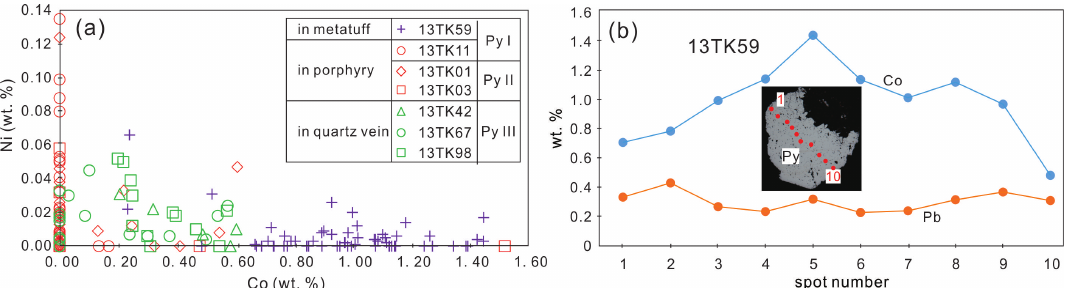
Figure 9. ( a ) A nickel versus cobalt plot for pyrite hosted in porphyry, metatuff, and quartz veins; ( b ) A diagram showing a profile of cobalt and lead concentration for an euhedral pyrite of metatuff (13TK59) from the Tongkuangyu Cu deposit, North China Craton; Note that euhedral pyrite exhibits gradual enrichment toward core and different pyrite exhibits different concentrations in the two